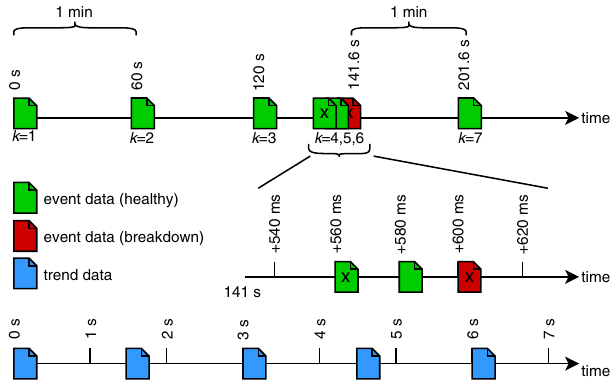
FIG. 6. Trend and event data logging. Event data signals